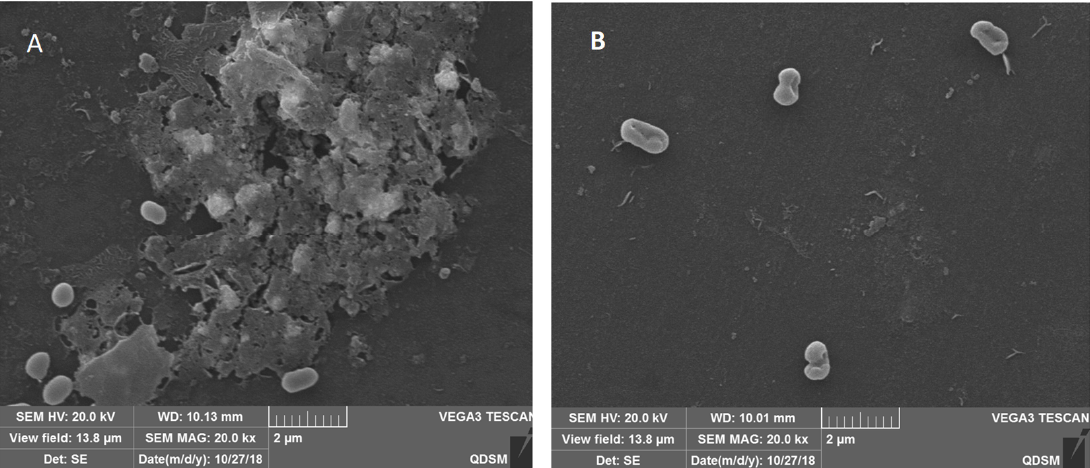
Figure 4. The representative scanning electron microscopy (SEM) images of biofilm structures of V. parahaemolyticus incubated in 24-well microplates for 24 h: ( A ) control; ( B ) combined enzyme treatment (20,000 × ).